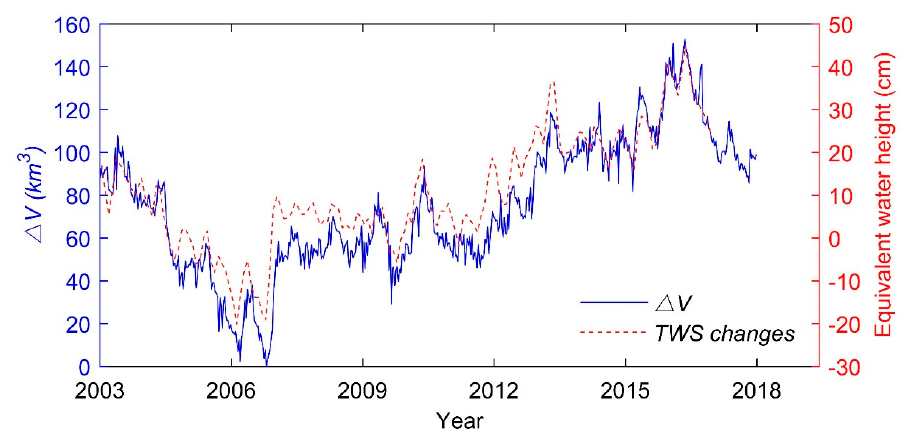
Figure 9. Time series of the ∆ V (2003–2017) from the ∆ V - ∆ H relationship and the TWS changes (2003 and 2016) from GRACE data.